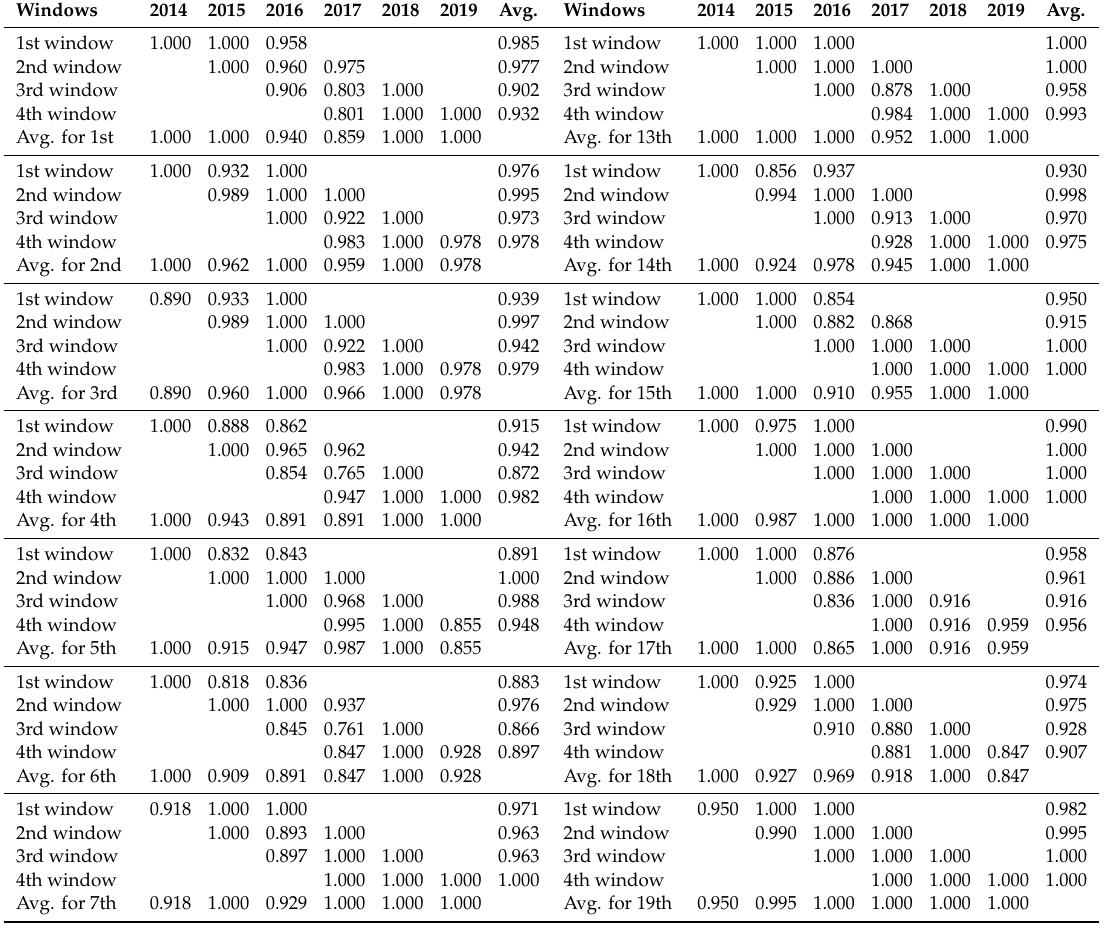
Table 11. Window analysis for CCR